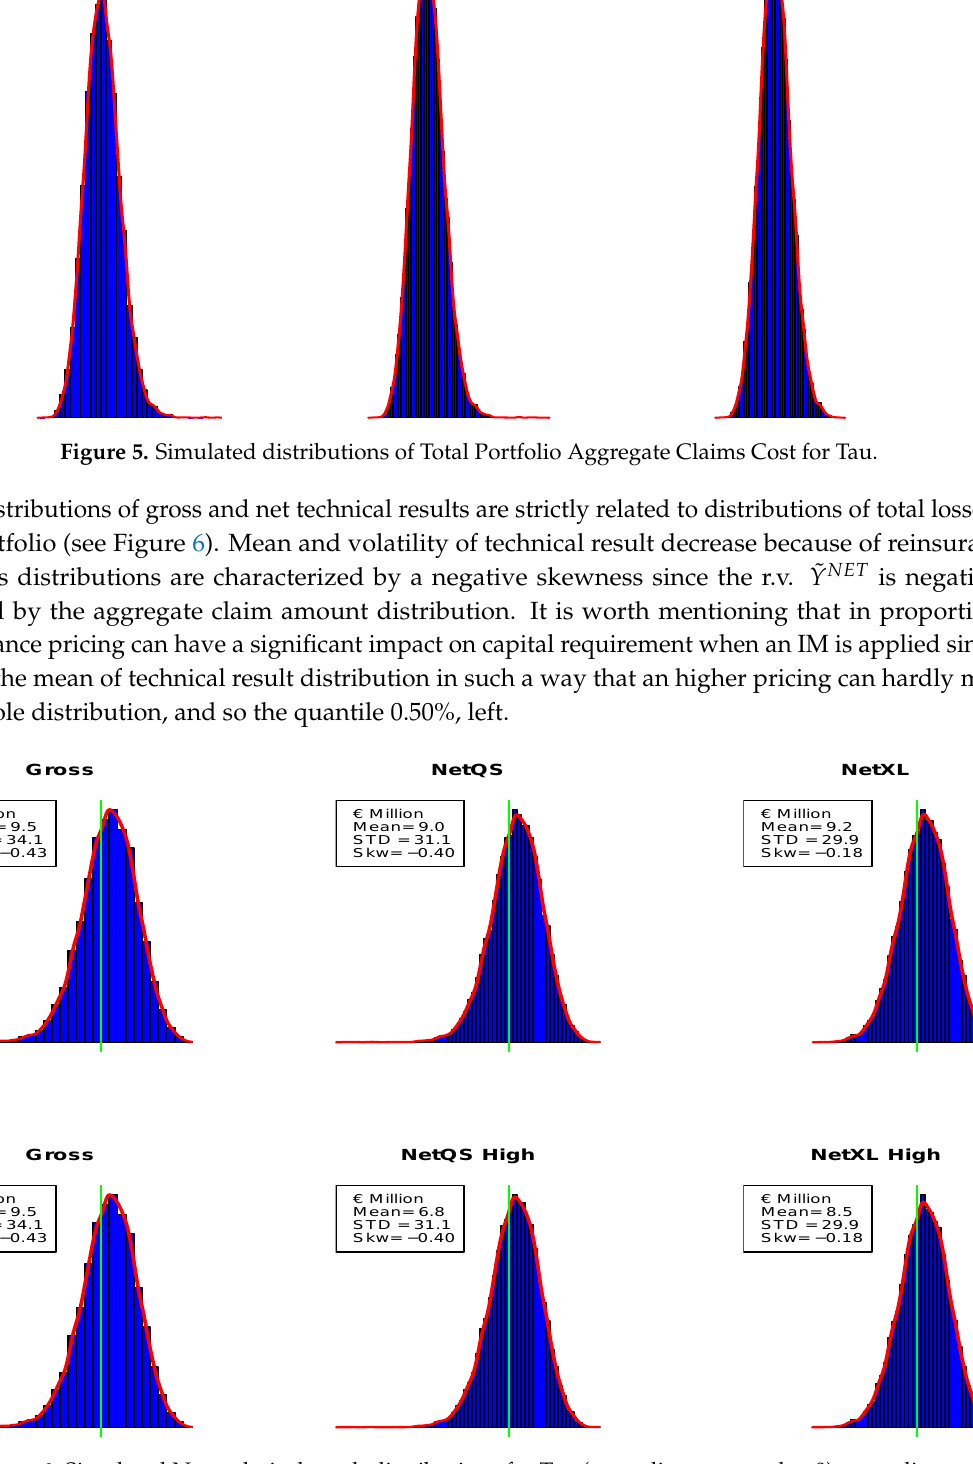
Figure 6. Simulated Net technical result distributions for Tau (green lines on x -value 0), according to different reinsurance